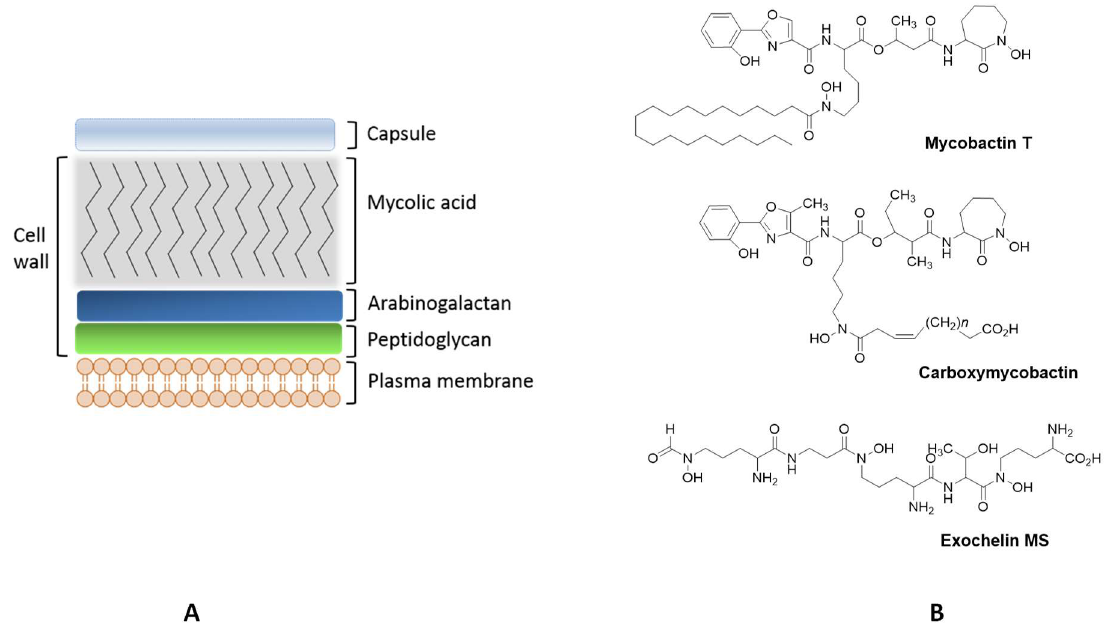
Figure 2. Schematic representation of the cell envelope of pathogenic mycobacteria ( A , adapted from [74]); Structure of mycobacterial siderophores: Mycobactin T produced by M. tuberculosis (MB T); Carboxymycobactin synthetized for M. avium , M. tuberculosis e M. bovis ( n = 2–9); Exochelin MS produced for M. smegmatis . ( B , adapted from [76–78]).